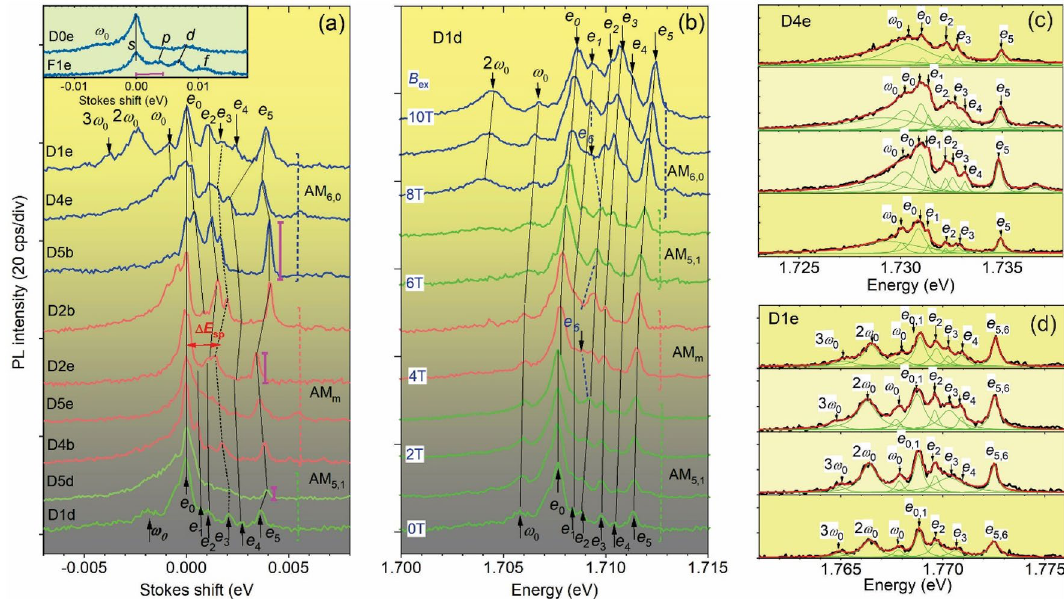
Figure 1. PL spectra of D kx anomalous InP/GaInP 2 QDs at zero external magnetic field B e . Solid lines connect the corresponding PL peaks, dashed ones connect peak e 3 . The upper insert shows PL spectra of two normal dots D0e ( N ~ 8, Δ E sp ~ 4.5 meV) and F1e ( N ~ 12, Δ E sp ~ 3.5 meV) and the horizontal bar indicates the spectral range of anomalous dots ( a) . PL spectra of the QD D1d in external magnetic fields B e = 0, 1, 2 … and 10 T (b) . Spatially resolved NSOM spectra ( B e = 0 T) of D4e (c) and D1e (d) QDs, respectively, taken at tip positions separated by 50